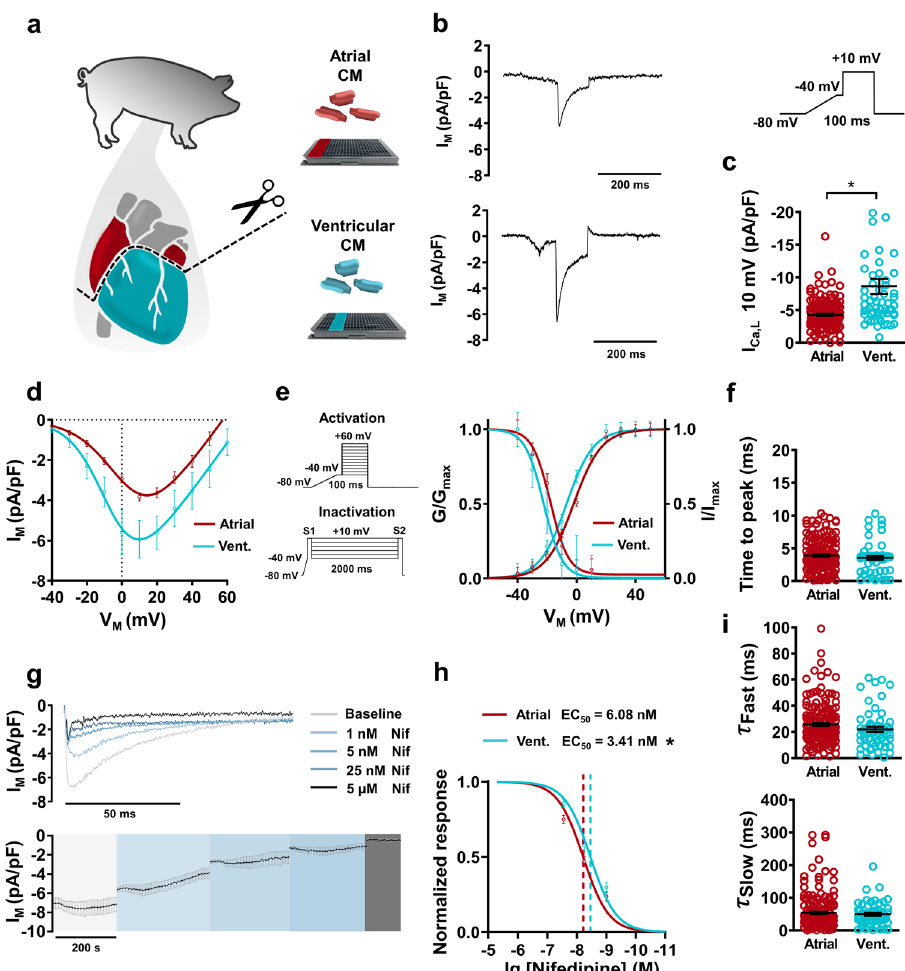
Fig. 3 L-type calcium current ( I Ca,L ) acquisition and analysis from native atrial and ventricular cardiomyocytes (CM) using automated patch-clamp. a Schematic of swine cardiac tissue harvesting and CM isolation. b Representative recordings of membrane current ( I M ) showing I Ca,L in atrial and ventricular (vent.) CMs. Inset: Voltage protocol. c Peak I Ca,L density measured at + 10 mV. d Current – voltage ( I – V ) relationship curves for I Ca,L in atrial ( n = 71) and ventricular ( n = 26) CMs. e Voltage protocols for I – V /activation experiments and S1/S2 voltage protocols for I Ca,L inactivation. Graph shows G / G n = 71) and ventricular ( n = 26) CMs, with corresponding inactivation( I / I n = 15) and ventricular I Ca,L activation ( max ) in atrial ( max ) curves in atrial ( ( n = 6) CMs. f Activation kinetics of I Ca,L at + 10 mV expressed as a time to peak amplitude. g Representative concentration-dependent response to nifedipine (Nif) application in I Ca,L current with a time course of average I Ca,L from a single plate following nifedipine application ( n = 10). h Concentration- response curve of I Ca,L (normalized to the current amplitude at the full block with 5 µ M Nif) following nifedpine application in atrial and ventricular CMs with corresponding half maximal effective concentration (EC50). I Biphasic inactivation kinetics of I Ca,L at + 10 mV expressed as fast decay ( τ fast) and slow decay ( τ slow). Data are mean ± SEM from three animals. *P < 0.05 vs. ventricular. n = number of atrial (176) and ventricular (58) CMs from 3 animals ( c , f , i ) or atrial (94) and Ventricular (39) ( h